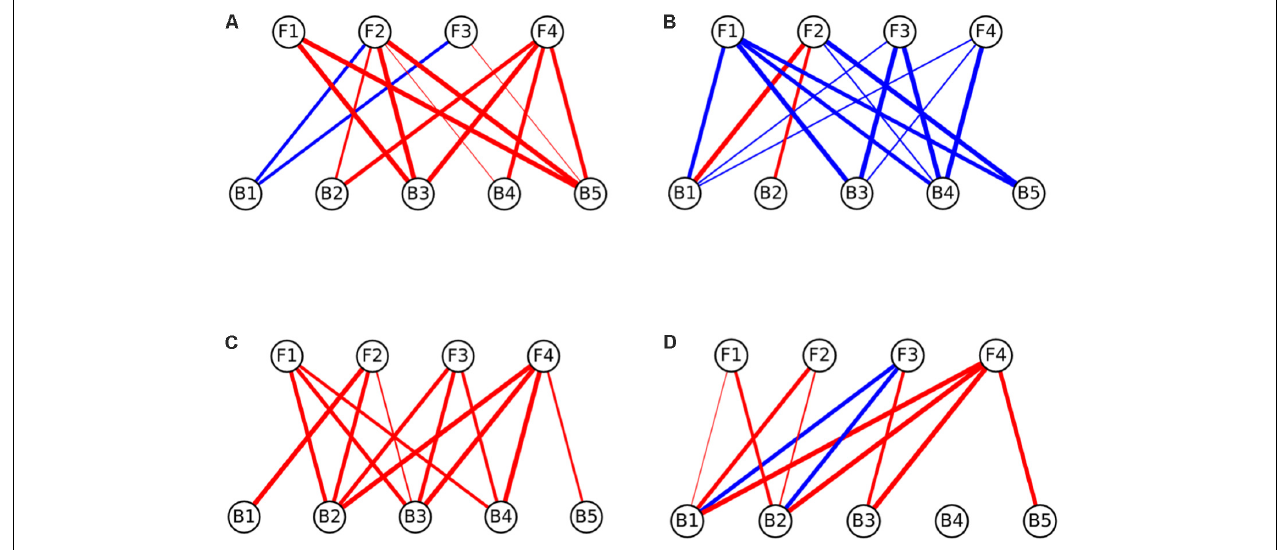
FIGURE 3 | Interaction networks indicating the effects of fungi on bacterial colony growth on (A) CP medium, (B) MM medium, (C) PDA medium, and (D) LB medium. Circles on the top row represent fungal isolates, while circles on the bottom represent bacterial strains. Blue lines represent interactions where fungi enhanced the growth of bacteria (induction), while red lines represent interactions where fungi inhibited the growth of bacteria (repression). The width of the line denotes the strength of the observed interactions (see section “Materials and Methods”). Strains abbreviations are as follows: F1: Coprinellus micaceus 1; F2: Cladosporium sp.; F3: Coprinellus micaceus 2; F4: Aspergillus niger ; B1: Aeromonas sp. 1; B2: Vibrio sp.; B3: Aeromonas sp. 2; B4: Aeromonas sp. 3; B5: Aeromonas sp. 4.